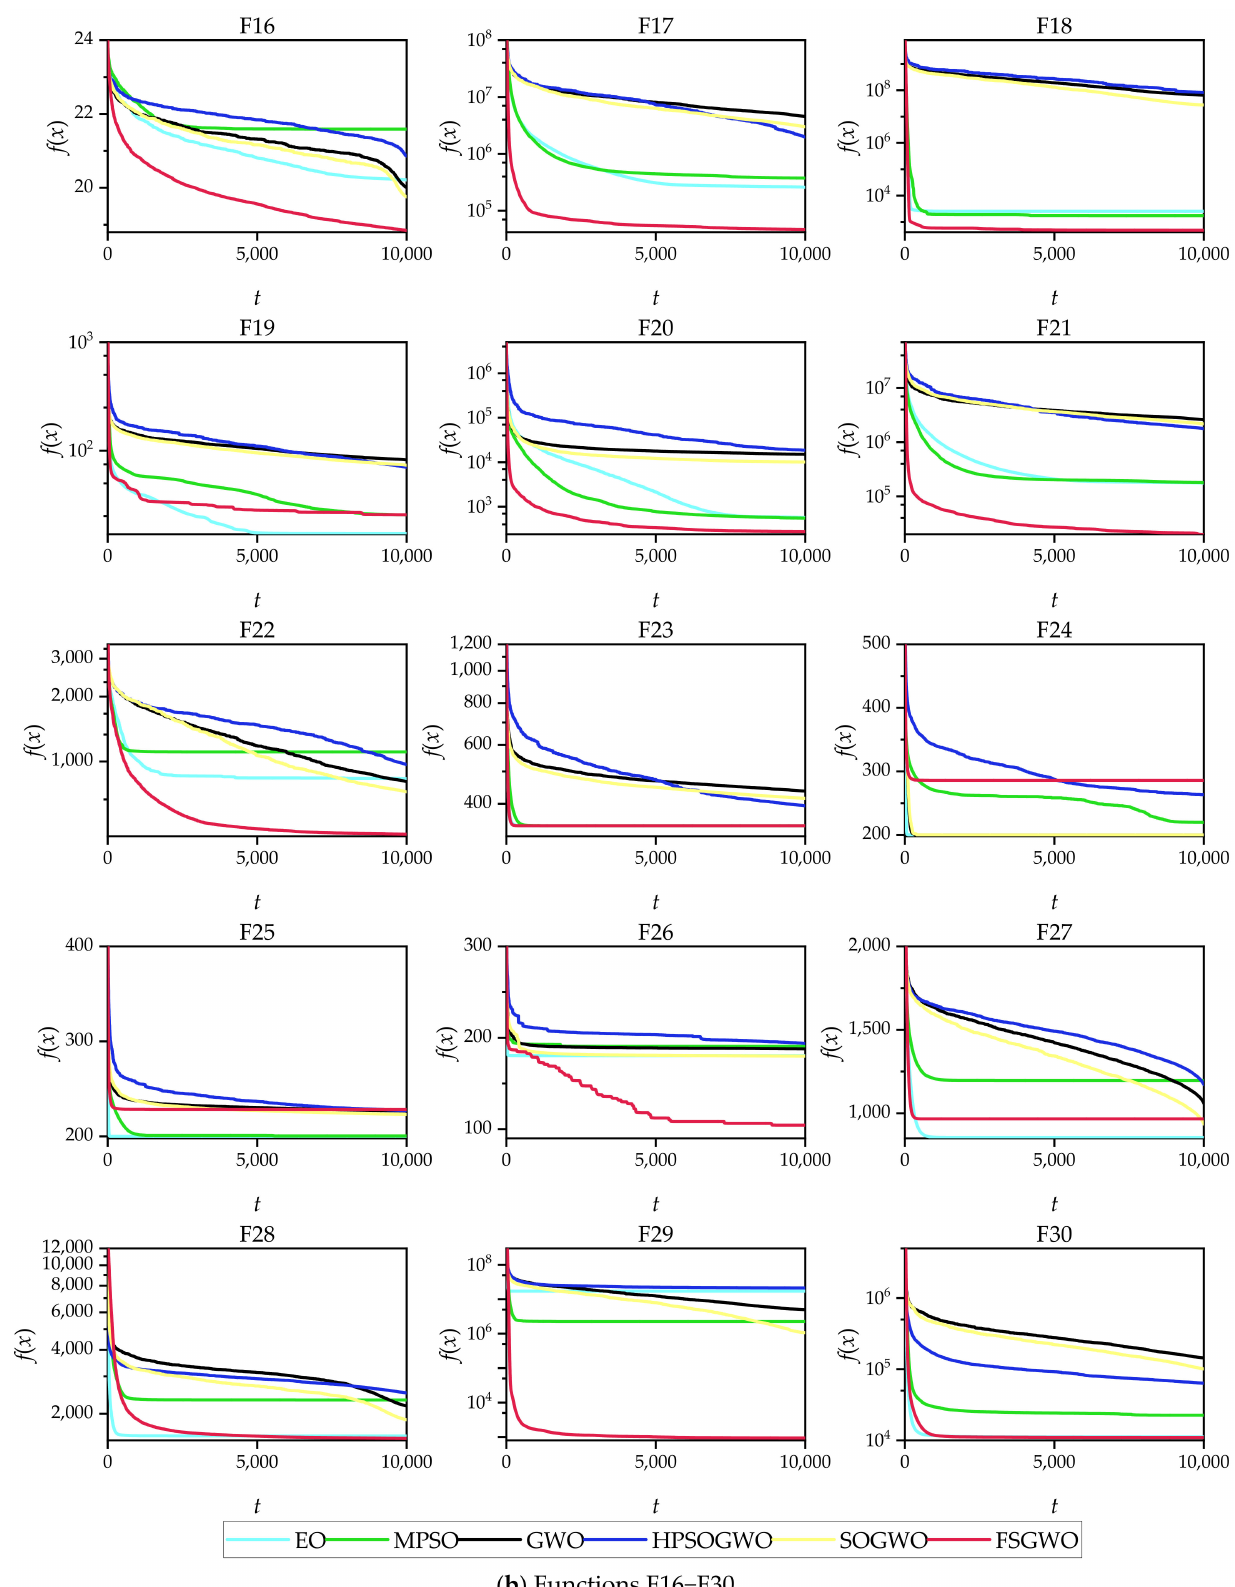
Figure 4. Convergence curves of the related algorithms for 50-dimensional